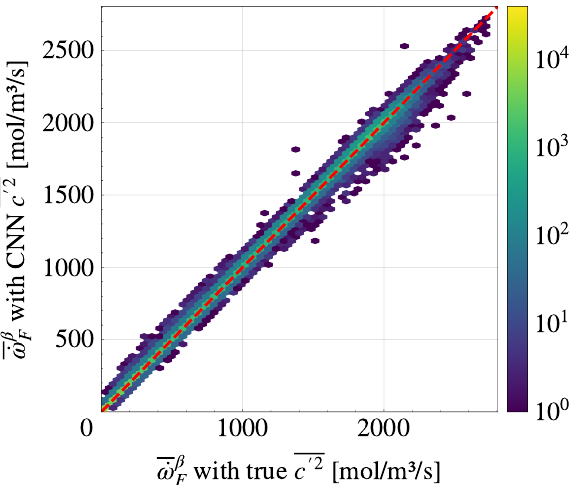
Figure 14. Hexbin plot of beta PDF reaction rates with CNN values of c (cid:48) 2 against beta PDF reaction rates with true values of c (cid:48) 2